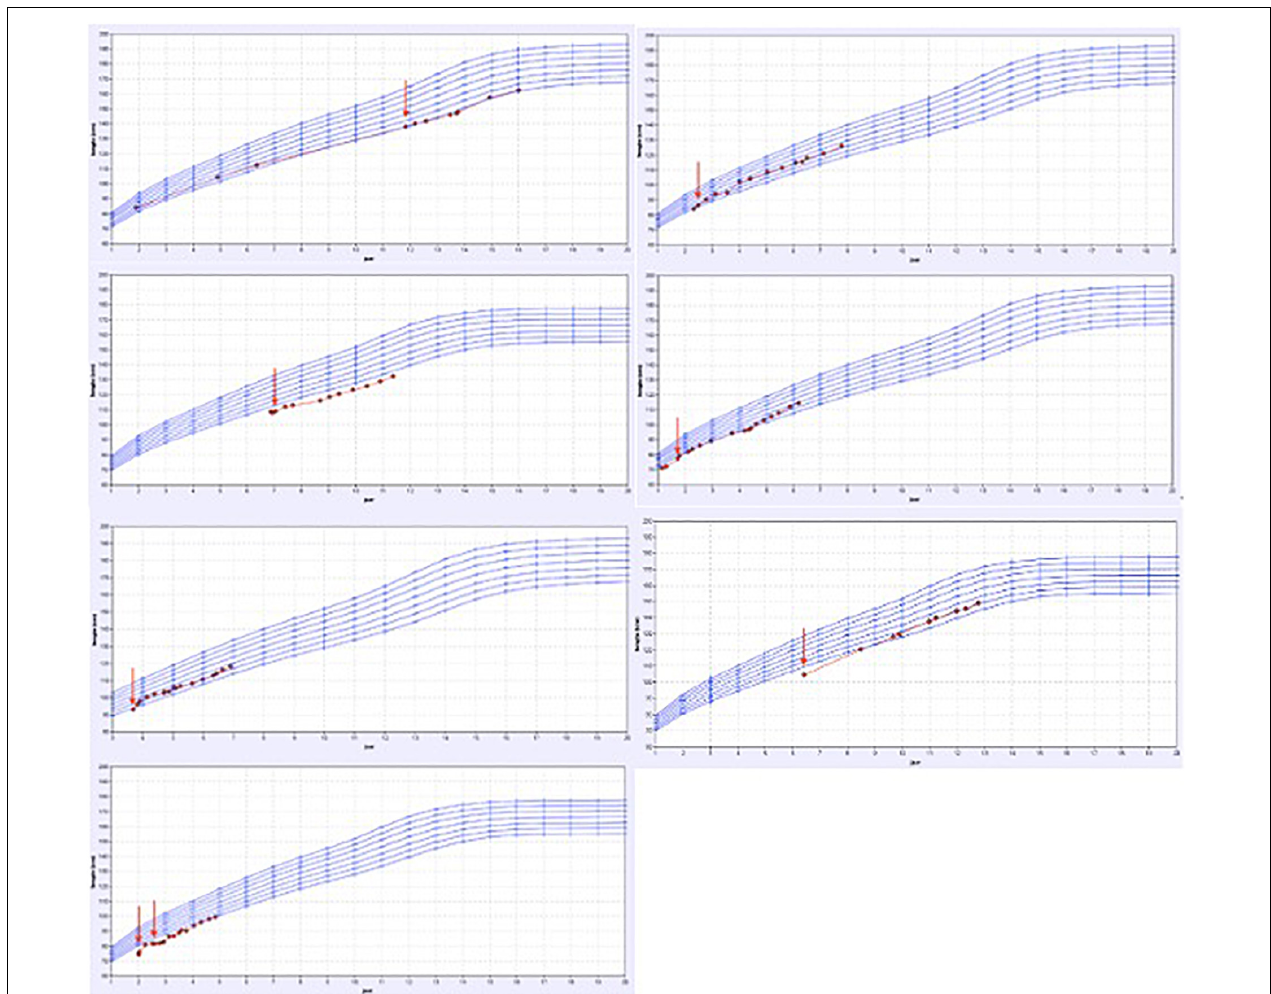
FIGURE 4 | Overview of the growth charts of patients without a proven tubulopathy but who did have a catch-up in growth after treatment. X-axis: the age in years and Y-axis: height in cm. The red arrow shows the time point the treatment with specific oral electrolyte supplementation was initiated.